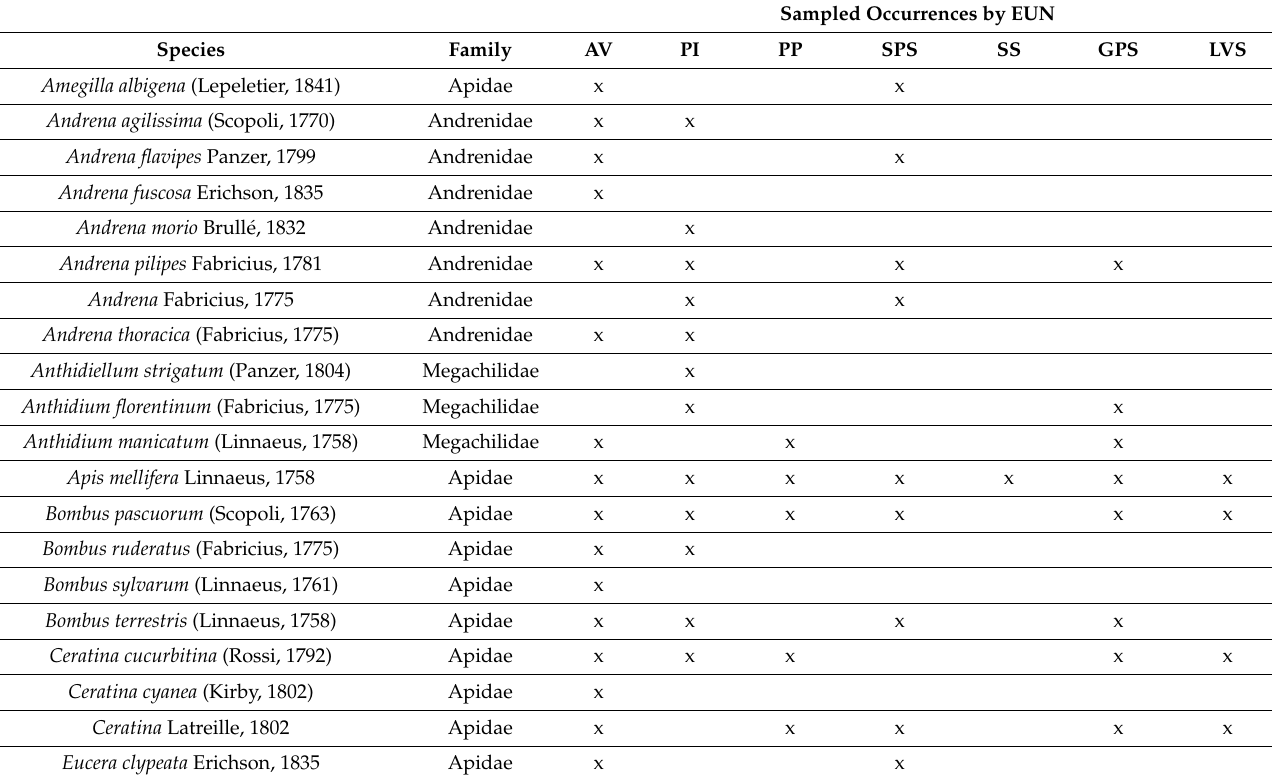
Table A1. List of detected bee taxa and their occurrence by environmental unit type (EUN). All the taxa are wild and native to the study area except for Apis mellifera (managed species) and Megachile sculpturalis (introduced species). EUNs codes: AV = Alluvial valleys, PI = Pyroclastic impluvia, PP = Pyroclastic plateaus, SPS = Steep pyroclastic slopes, SS = Sedimentary clayey and sandy hill slopes, GPS = Gentle pyroclastic slopes, LVS = Lithoid volcanic slopes. Sampled Occurrences by EUN Species Family AV PI PP SPS